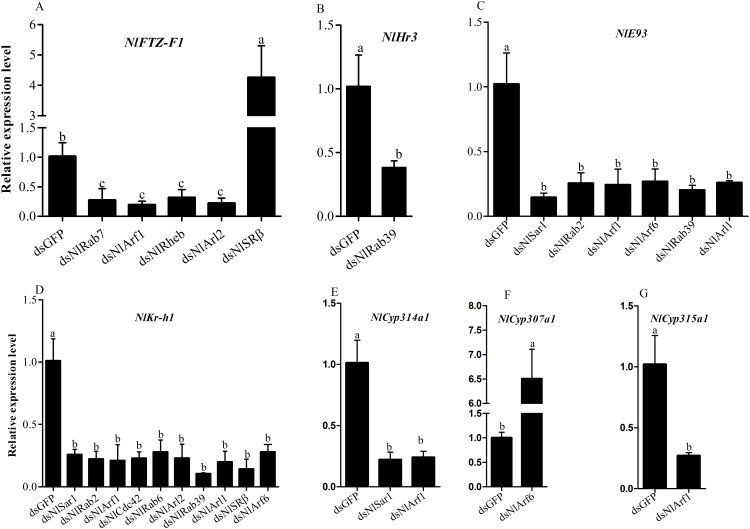
qRT-PCR analysis of genes expressions in the nymphs injected with dsGFP and dsRSGs.Error bars represent the standard deviation in three independent RNAi experiments. Different letters indicate a significant difference at P <0.05.